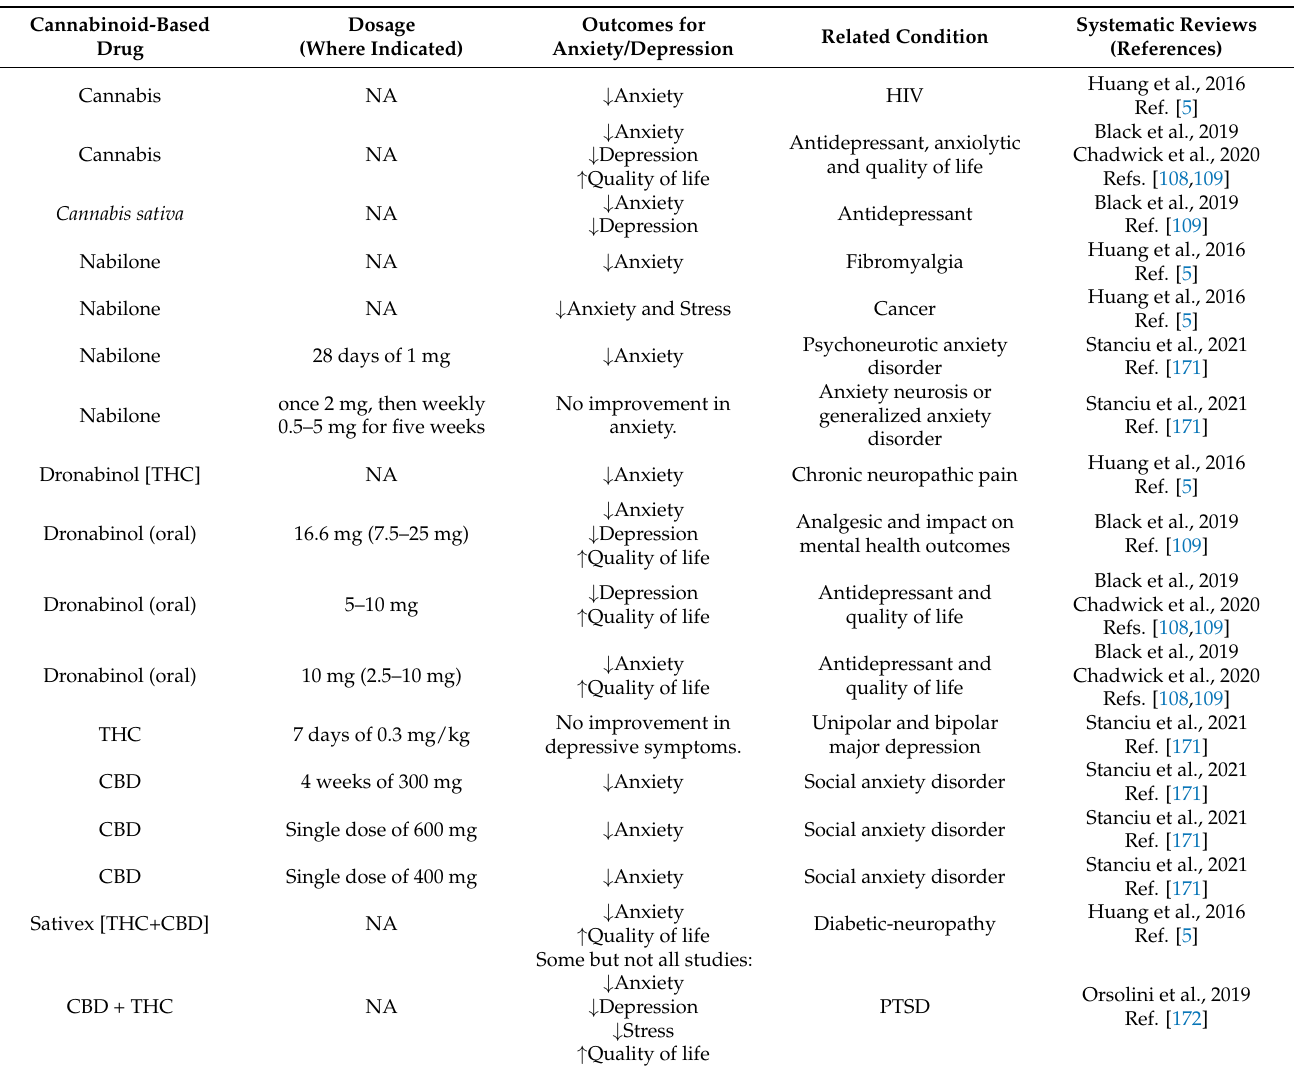
Table 2. Examples of cannabinoid-based therapies to treat anxiety and/or